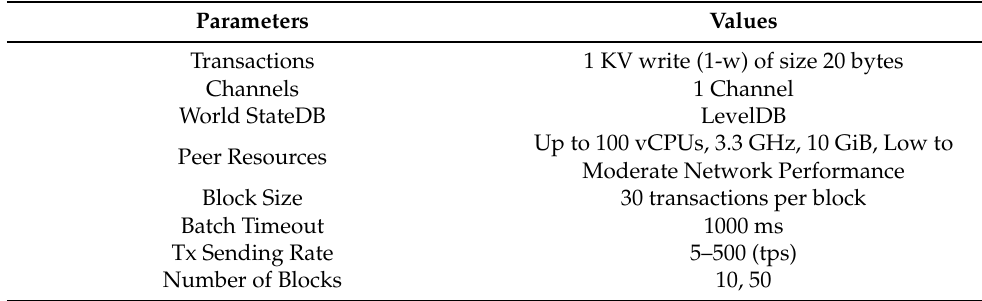
Table 1. SUT parameters and metrics. Parameters